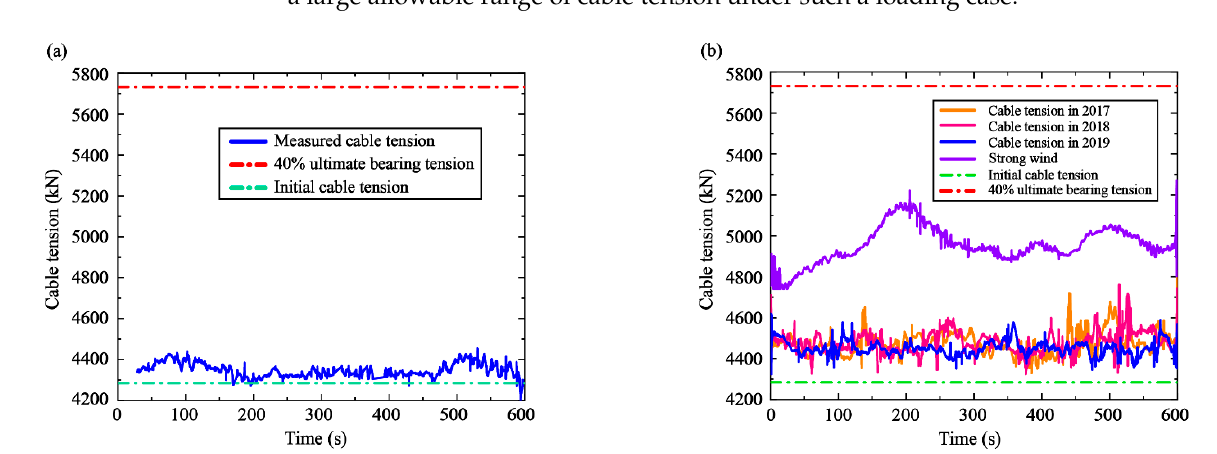
Figure 18. Assessment of service performance of the cable. ( a ) Results of the field experiment and ( b ) identified cable tension from 2017 to 2019 and an abnormal condition during strong winds.